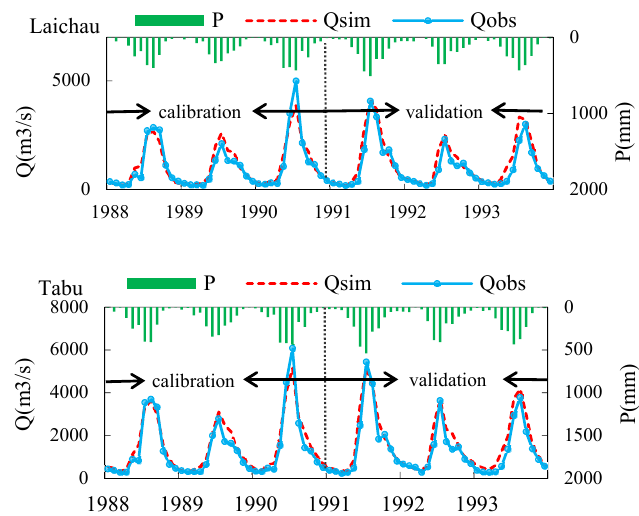
Figure 5. Comparison of observed and simulated monthly streamflow in the DRB.